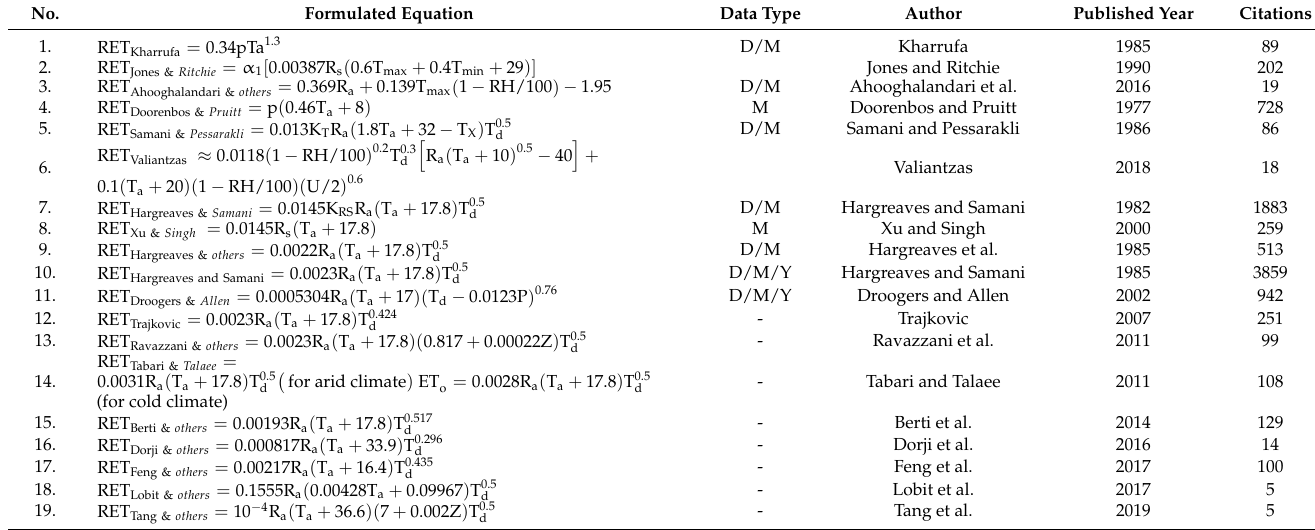
Table A4. RET temperature-based